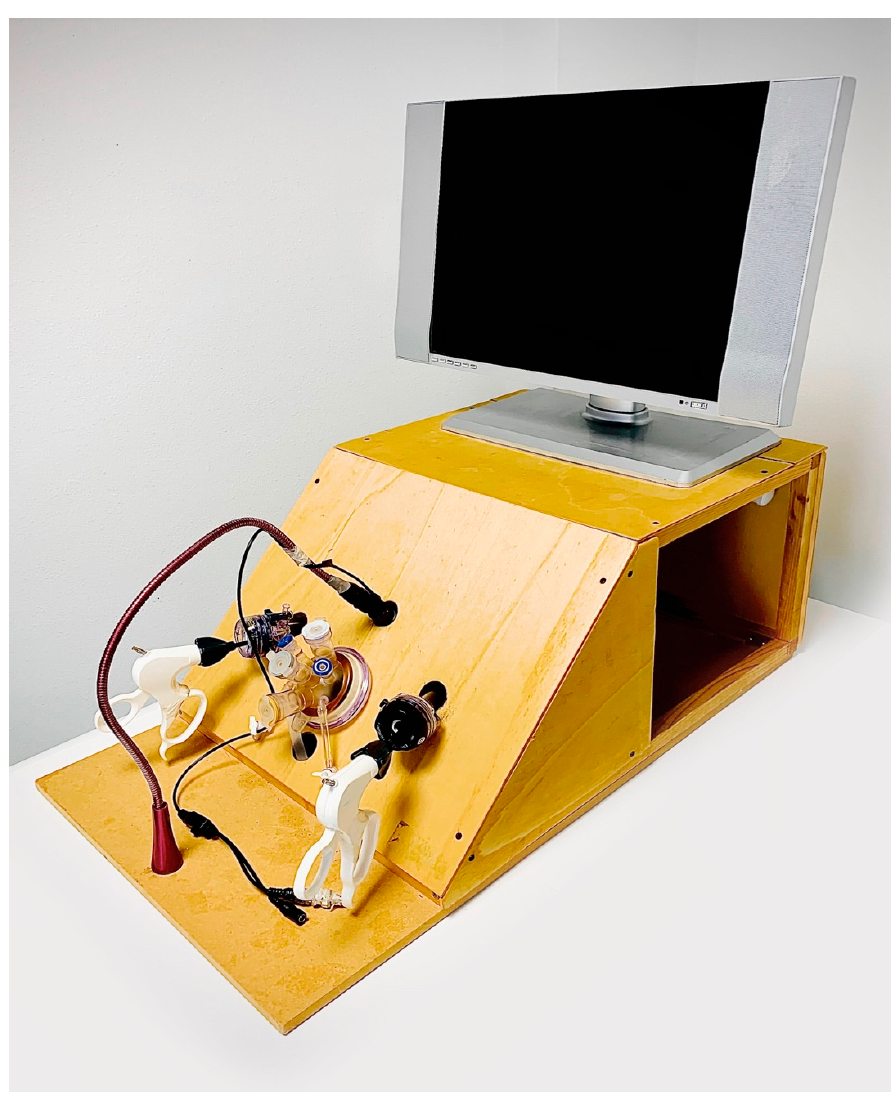
Figure 1. Overview of LABOT.